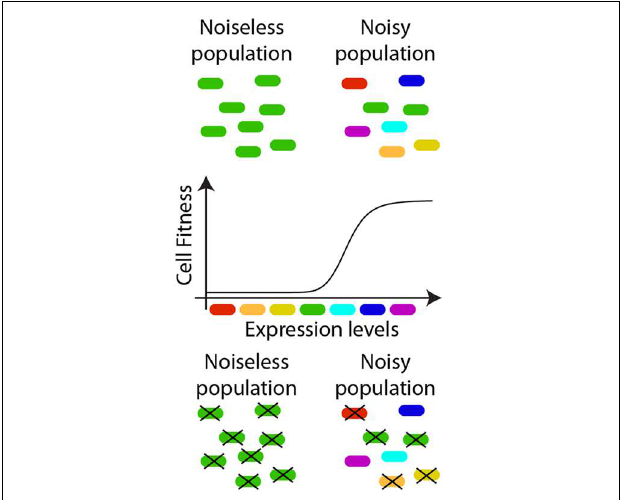
FIGURE 2 | Noise as a positive regulator of cellular behavior. Variability in protein expression levels among isogenic individuals might improve the overall performance of a cell population. Boxes of different colors are used to represent cells where a protein (or a set of proteins), critical for the cell survival, is differently expressed among the individuals of an isogenic population. When the population is featured by limited phenotypic variability (left hand side of the lower diagram), different cells have comparable expression levels. In a noisy population (right hand side of the lower diagram), the same average expression level, as accessible with bulk measurements, result from a more dispersed distribution of protein concentrations at the single-cell level. If the cell survival depends on the expression level of a given protein (i.e., only cells with expression levels corresponding to light-blue, blue, and purple boxes survive) a noisier population might be more robust to changes in environmental conditions causing selective stress, thereby ensuring the species survival. Similar strategies could be adopted to improve sensing properties in synthetic applications.